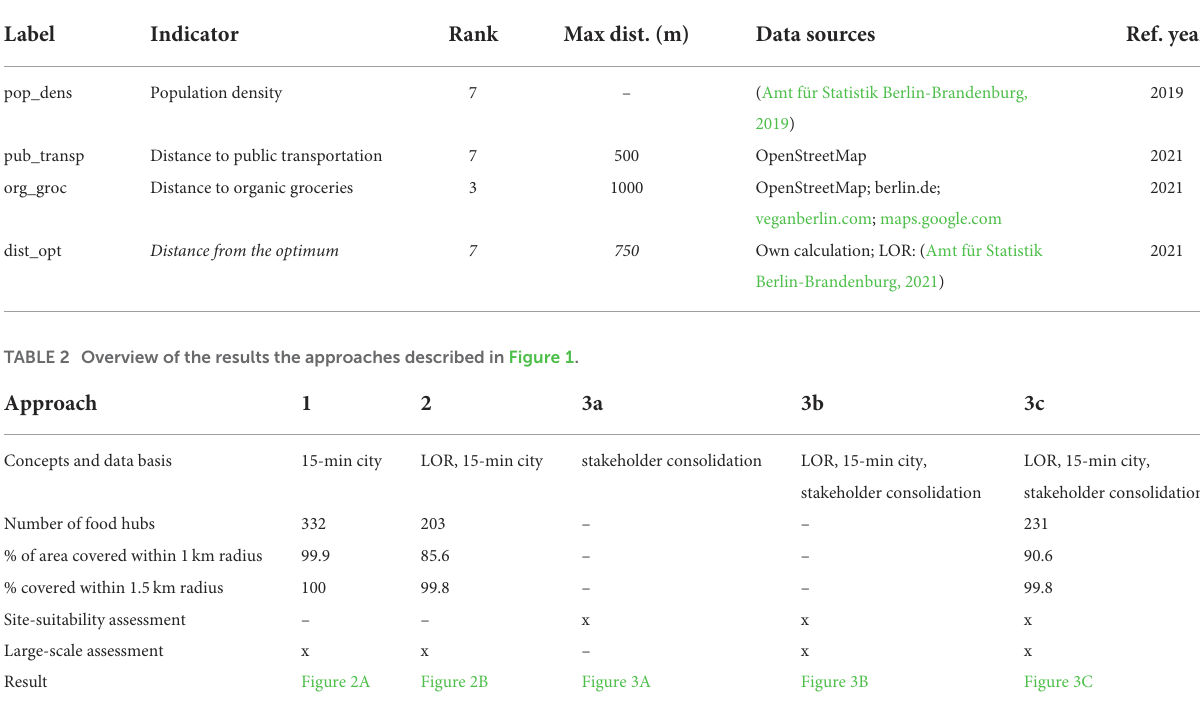
TABLE 1 Label, name and rank given by the stakeholders involved (except for dist_opt), maximum distance (when applied), data sources and reference year of the indicators for assessing the site-suitability of the food hubs in Berlin.